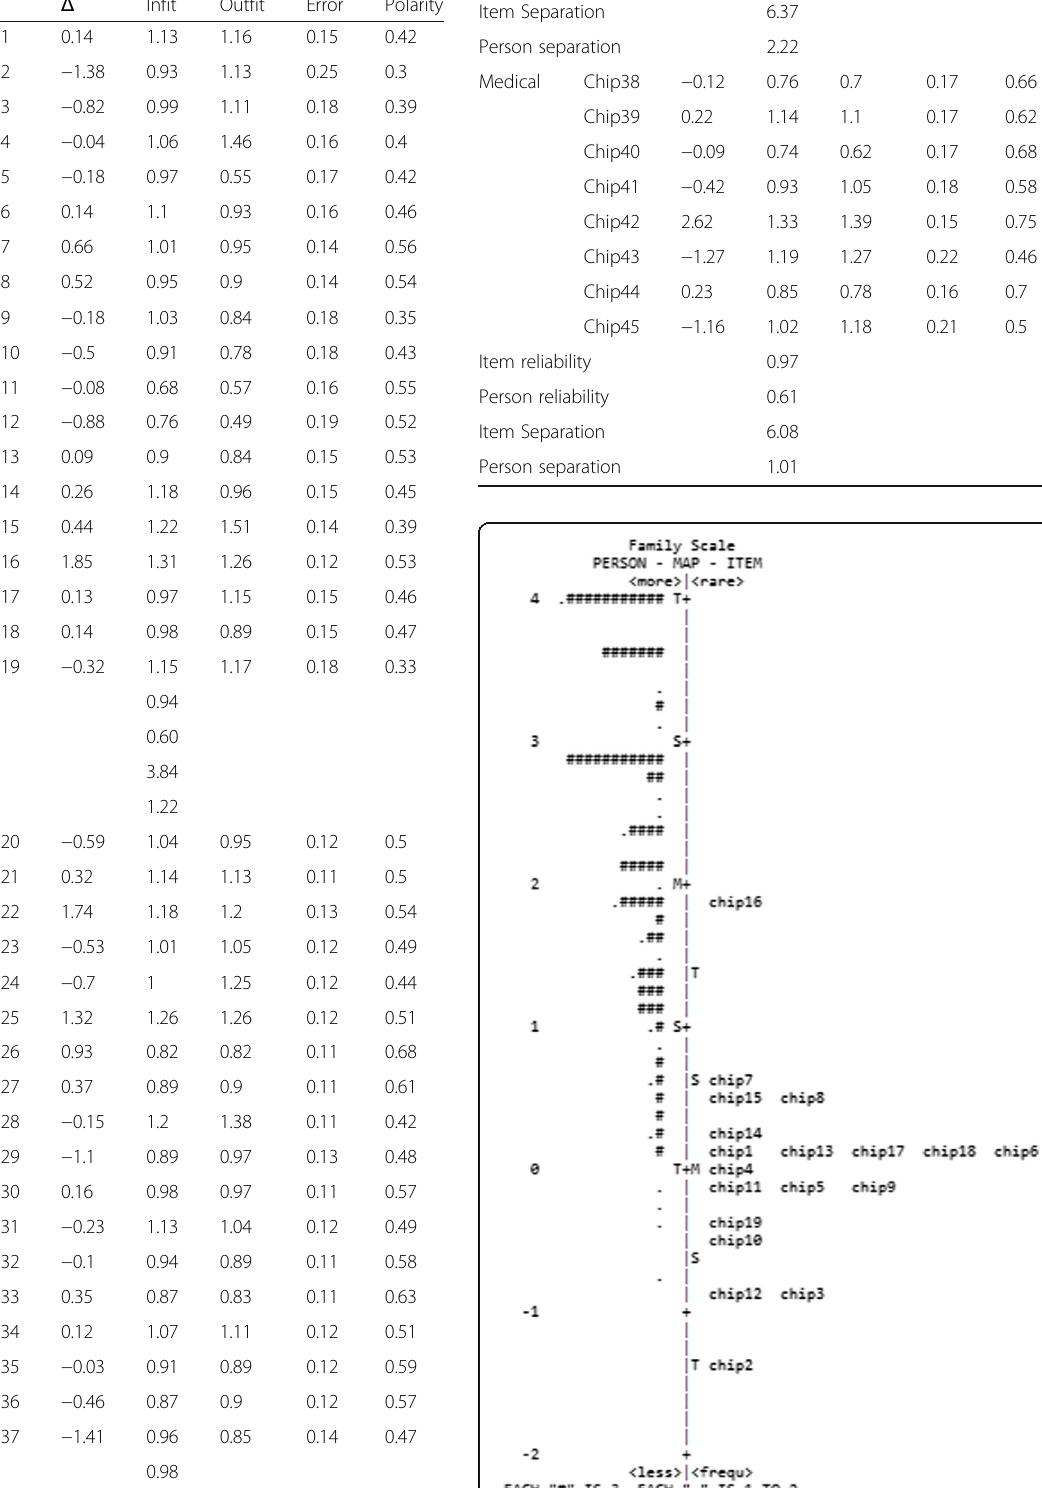
Fig. 1 Item-person map for the family dimension of the